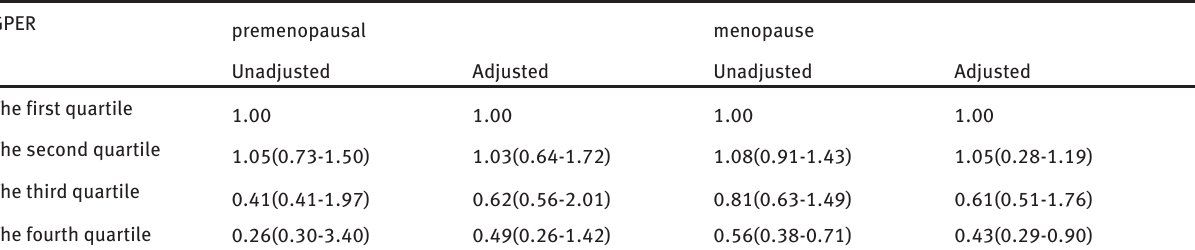
Table 3: Logistic regression analysis results for hypertensive in female with and without menopause